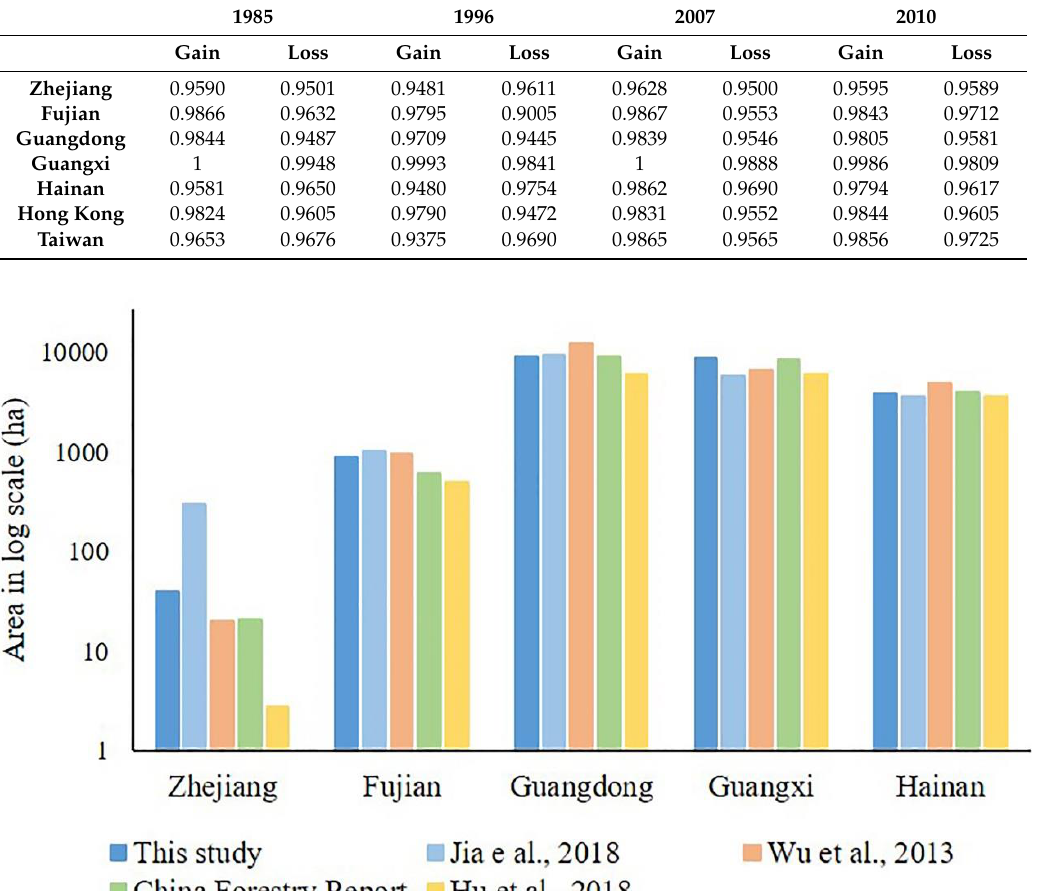
Table A2. The classification accuracies of change quantification in each province (district).